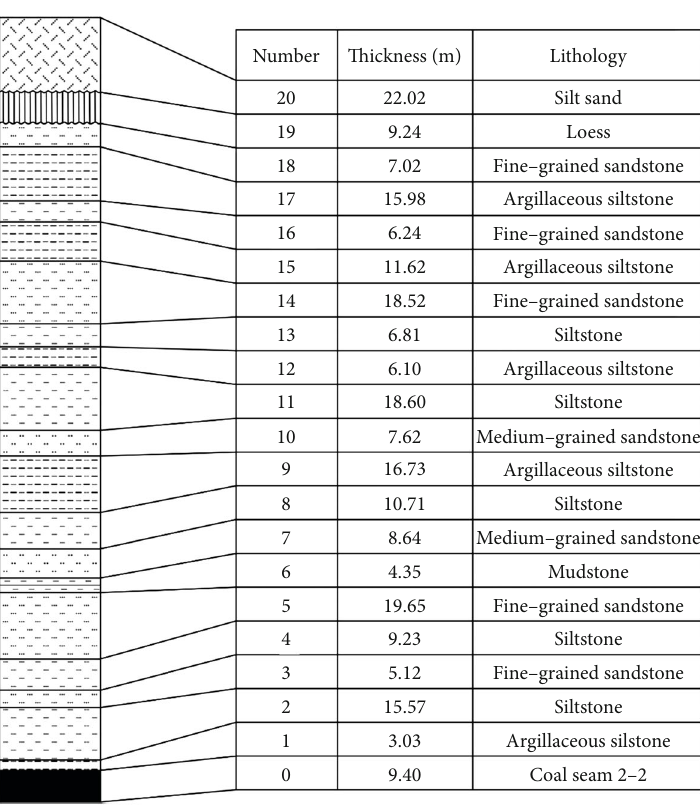
Figure 2: Typical geological log pro fi le of No. 101 panel overlying strata.